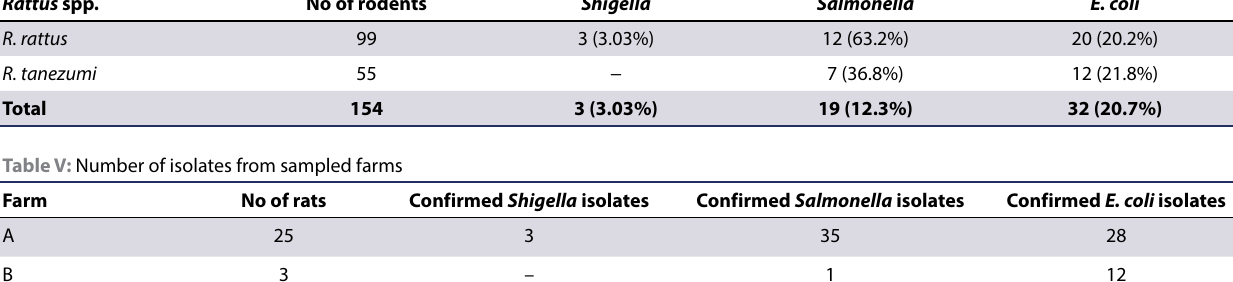
Table IV: The distribution of pathogens among Rattus species Rattus spp.